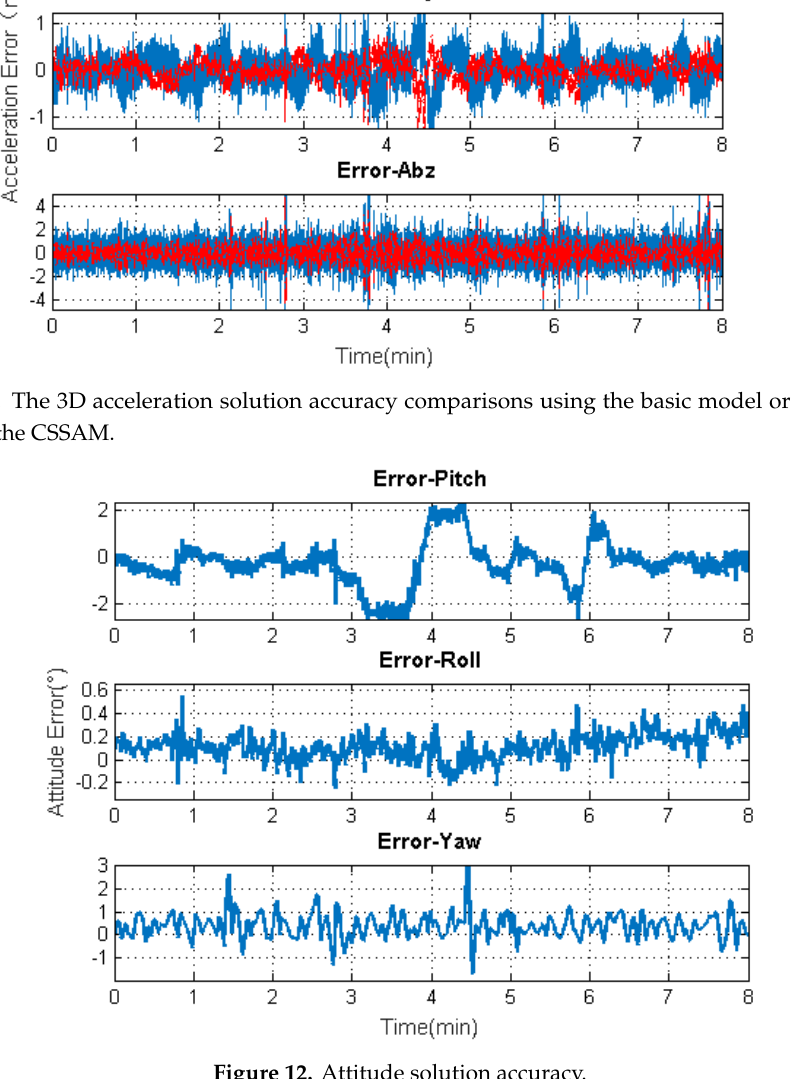
Figure 12. Attitude solution accuracy.